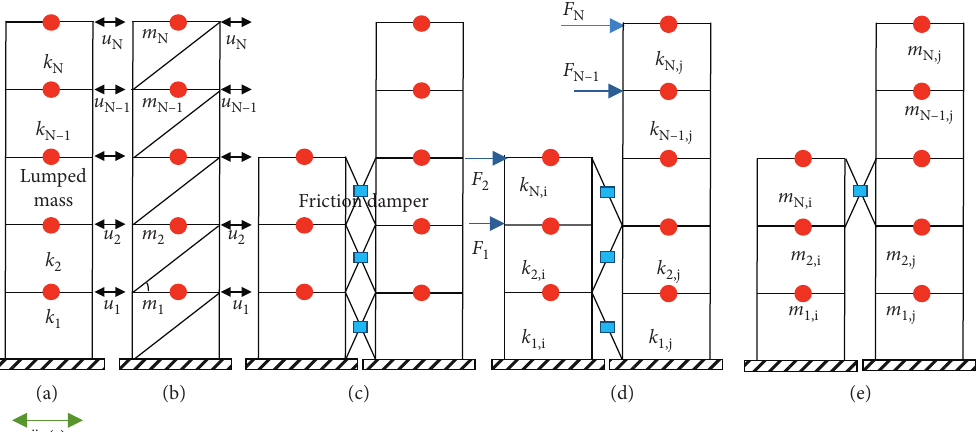
Figure 2: Mathematical models of N -storey: (a) unconnected (U) moment-resisting frame (MRF), (b) unconnected (U) braced frame (BF), (c) connected frames (configuration A), (d) connected frames (configuration B), and (e) connected frames (configuration C) for unequal storey